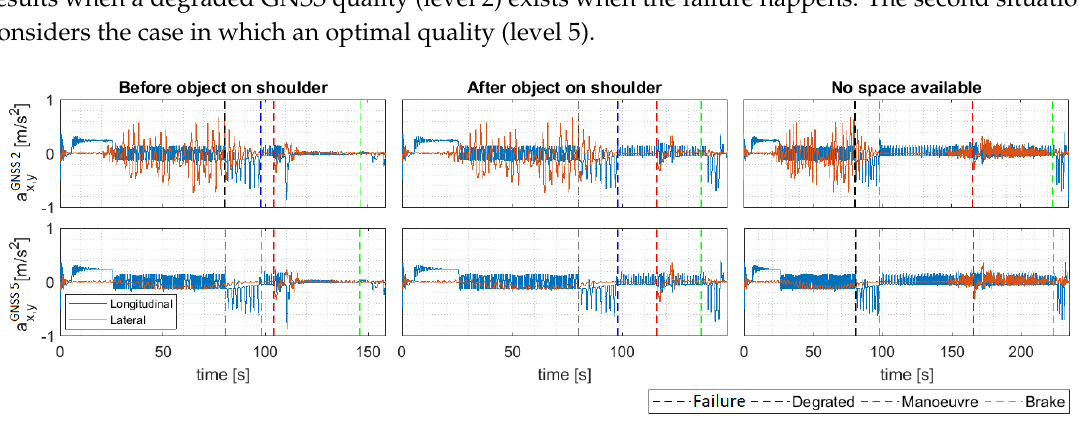
Figure 12. Longitudinal and lateral accelerations in DDT fall-back